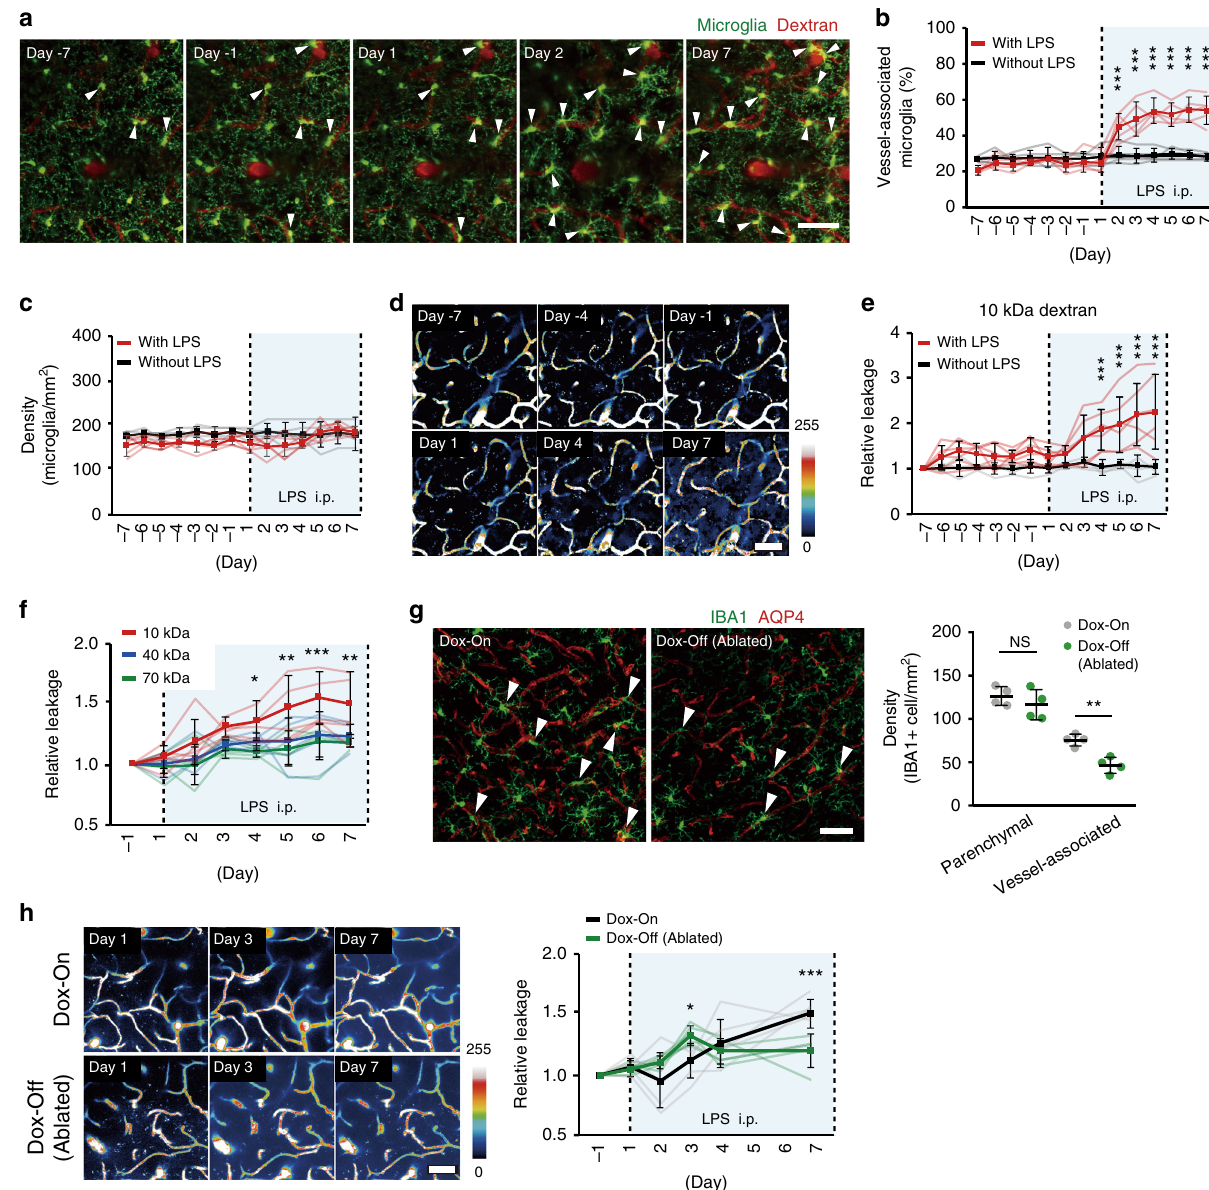
Fig. 2 The temporal relationship between microglia-vessel migration and BBB permeability during systemic in fl ammation. a Image series from a single mouse demonstrate the time course of microglia migration to cerebral vessels during the development of systemic in fl ammation induced by daily LPS injections. b Effects of daily LPS injections on the proportion of microglia in contact with cerebral vessels. Graphs show data from control (without LPS) and LPS (with LPS) experiments. Blue shadow indicates LPS injections (i.p.). c Effects of LPS on the total number of microglia in each image fi eld on each day. LPS had no signi fi cant effect on total microglial density. d A series of typical images from a single mouse demonstrates the time course of changes in BBB permeability after systemic LPS injection. e Effects of daily LPS injections or control on dextran leakage from blood vessels. The relative leakage of 10 kDa dextran was signi fi cantly increased from 4 to 7 days after LPS injection. f Quanti fi cation of the size selectivity of BBB permeability after systemic LPS injection using different molecular size dextrans. g Typical images (left panels) and mean data (right panel) show the effects of partial microglia ablation (Dox-Off) on the density of microglia in the brain parenchyma and associated with vessels. The density of vessel-associated microglia was signi fi cantly decreased in Dox-Off mice as compared with Dox-On mice. h A series of typical images from a single Dox-On (upper panels) and Dox-Off (lower panels) mouse illustrate the effects of microglia ablation on BBB permeability during systemic in fl ammation induced by daily LPS injection. Time course of BBB permeability changes during LPS injections Dox-Off and Dox-On mice. Microglia ablation induced a signi fi cant increase in BBB permeability during the early phase of systemic in fl ammation (Day 3) and a signi fi cant reduction in the later phase. In all line graphs, light lines indicate data from an individual animal ( b , c , e , f , h ), while the dark lines and error bars show mean ± SD. NS not signi fi cant. * P < 0.05, ** P < 0.01 and *** P < 0.001. Scale bars in all panels: 50 μ